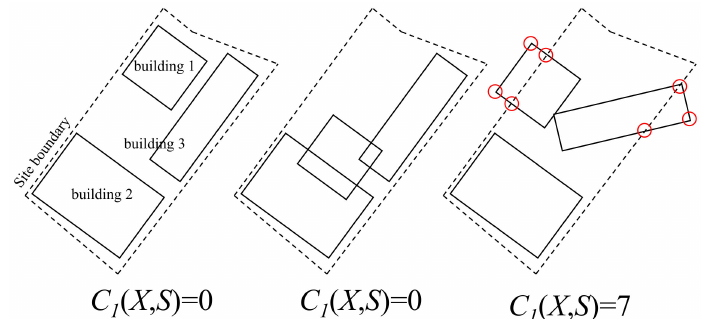
Figure 5. Value of the constraint function C 1 ( X , S ) for query